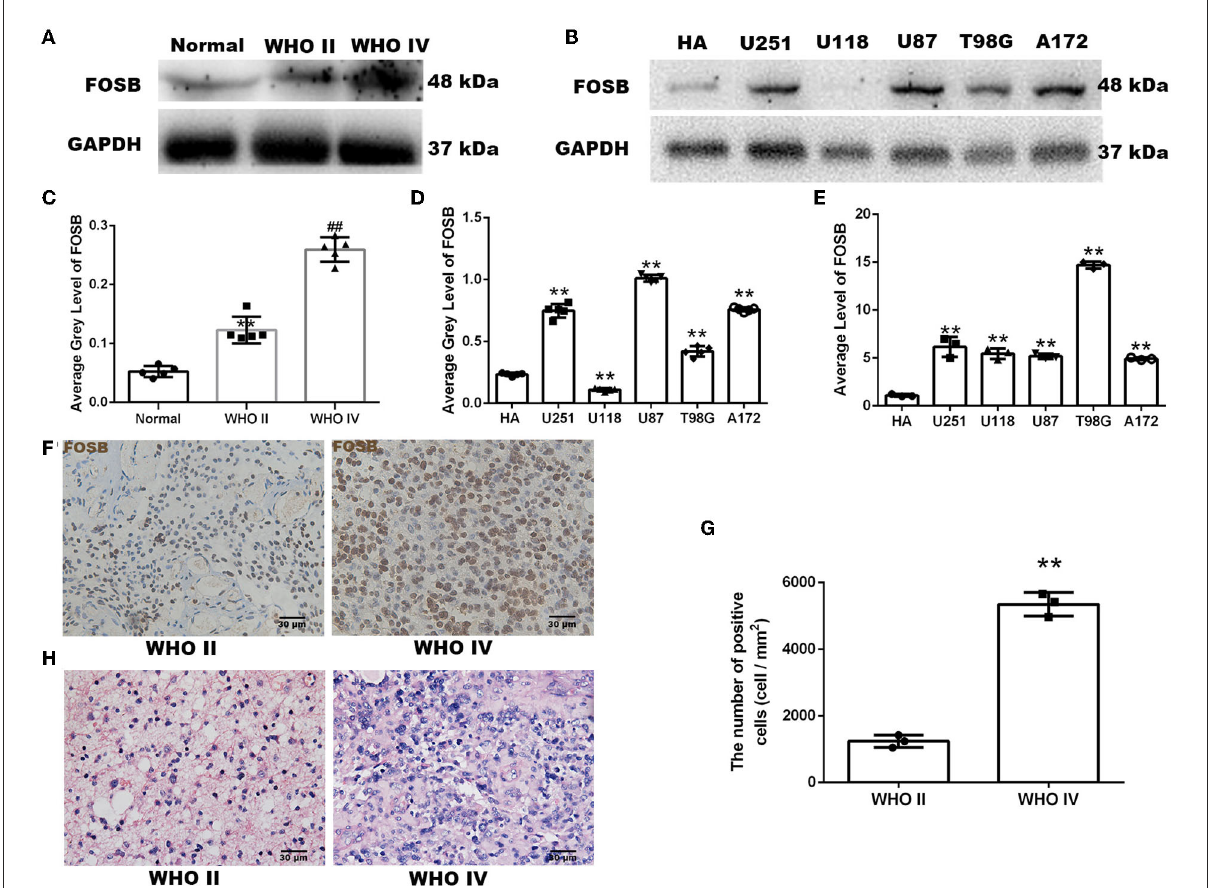
FIGURE1 Expression of FOSB in human glioma samples and glioma cells. (A) FOSB expression in normal brain samples, low-grade glioma, and high-grade glioma samples was determined by Western blot ( n = 5 each). (B) FOSB expression in normal human astrocytes and five glioma cell lines ( U251, U118, U87, T98G , and A172 ) was compared in vitro ( n = 3). (C) The quantitative analysis of (A) showed high FOSB expression in high-grade gliomas ( n = 5, ** P < 0.01 vs. normal brain tissues; ## P < 0.01 vs. WHO II glioma tissues). (D) The quantitative analysis of (B) showed higher expression of FOSB in glioma cell lines ( n = 3, ** P < 0.01). (E) FOSB expression in cell lines was detected by quantitative reverse transcriptase polymerase chain reaction (RT-qPCR). FOSB expression in glioma cell lines ( U251/U118/U87/T98G/A172 ) was also higher than that in human astrocytes (HA; n = 3, ** P < 0.01). (F) Immunohistochemistry was used to detect expression in low-grade and high-grade glioma samples ( n = 3). (G) The positive cell count of (F) showed high FOSB expression in high-grade gliomas ( n = 3, * P < 0.01 vs. low-grade glioma).